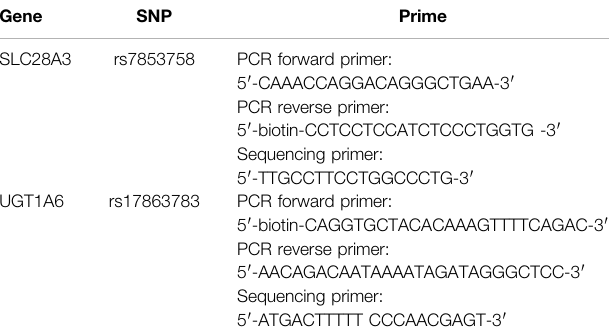
TABLE 1 | The pyrosequencing primer-set of SLC28A3 and